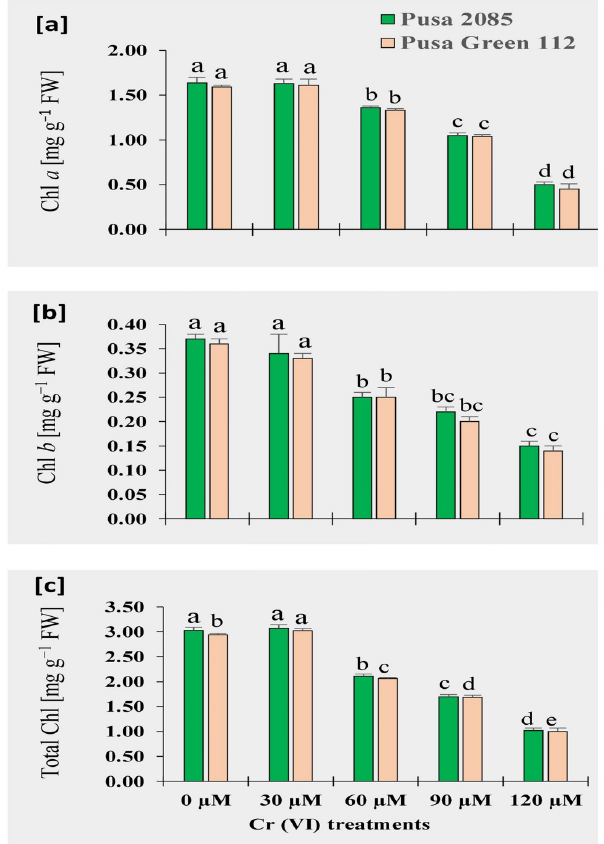
Fig 14. Effects of various chromium (Cr) concentrations on chlorophyll (Chl) contents of leaves in two chickpea varieties (Pusa 2085 and Pusa Green 112), grown in pots, 95 days after treatment (DAT). (a) Chl a . (b) Chl b . (c) Total Chl. Values are means ± standard errors from three independent experiments. Error bars with the same letters are not significantly different at p �